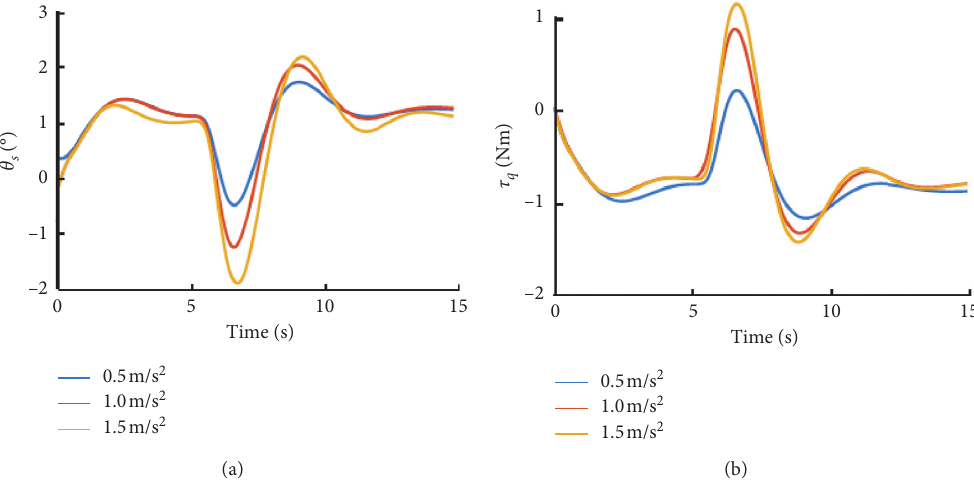
Figure 6: The results of bipedal robotic standing balance control with different acceleration. (a) Tilt angle. (b) Ankle